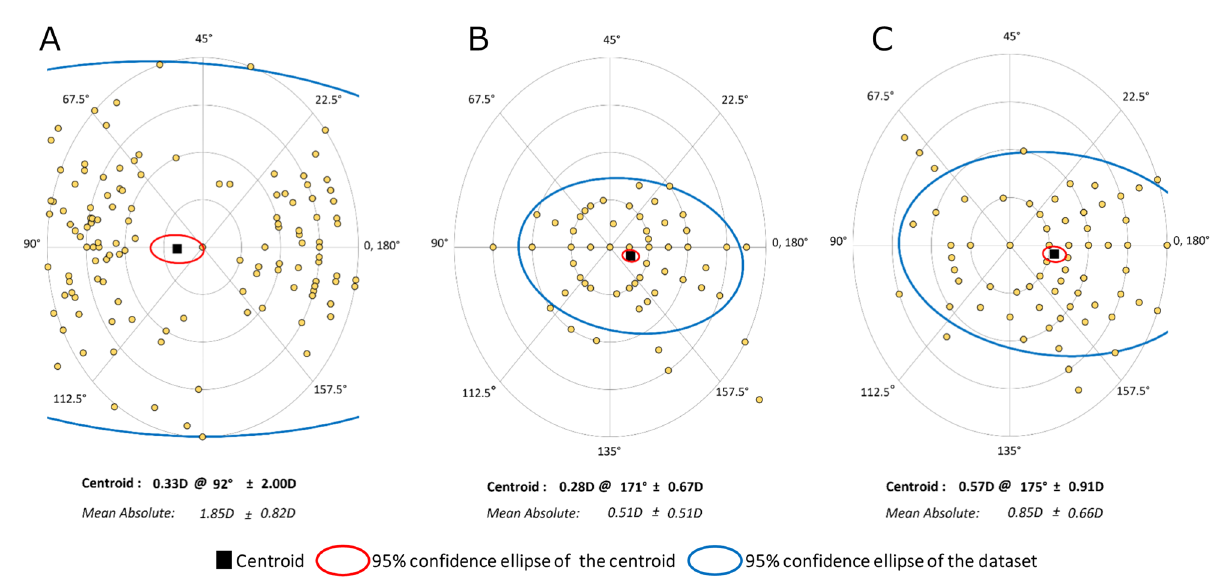
Figure 2. Double-angle plot analyses of preoperative corneal astigmatism ( A ), manifest astigmatism at 1 month postoperatively ( B ), and manifest astigmatism at 8 years postoperatively ( C ). Each ring = 0.5